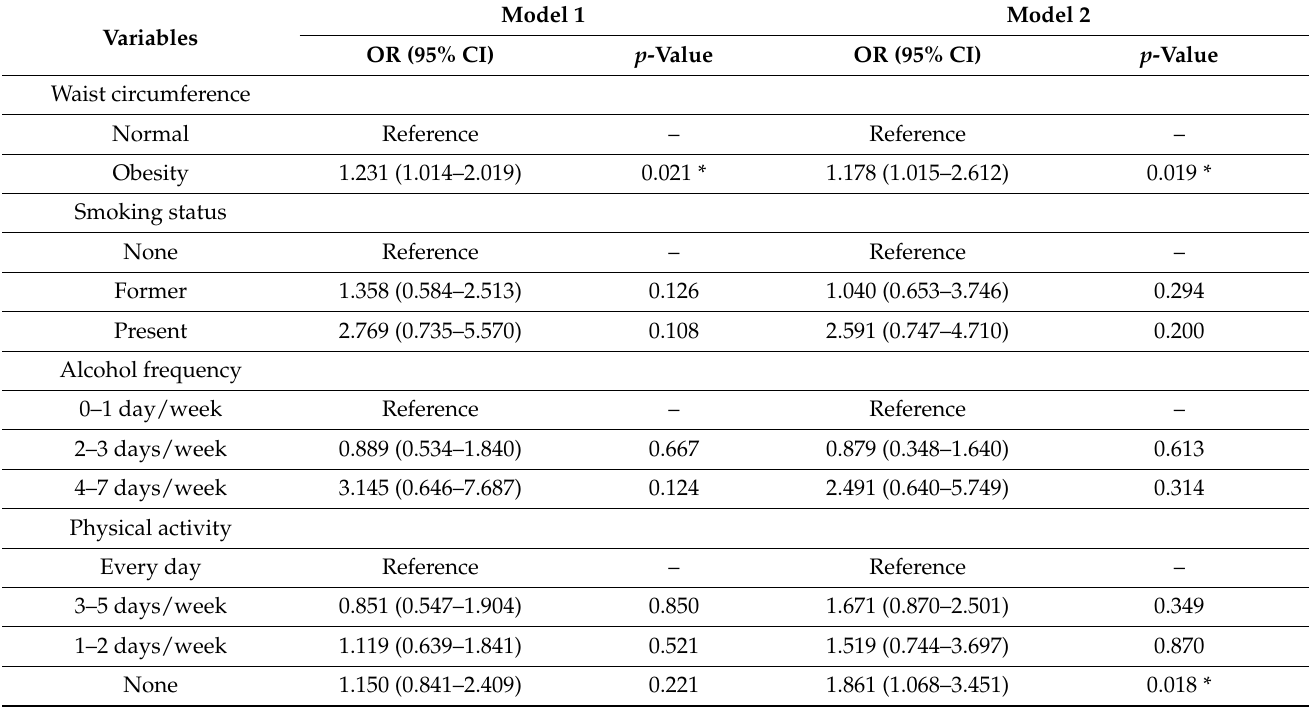
Table 4. Prevalence of colorectal polyp in women based on health